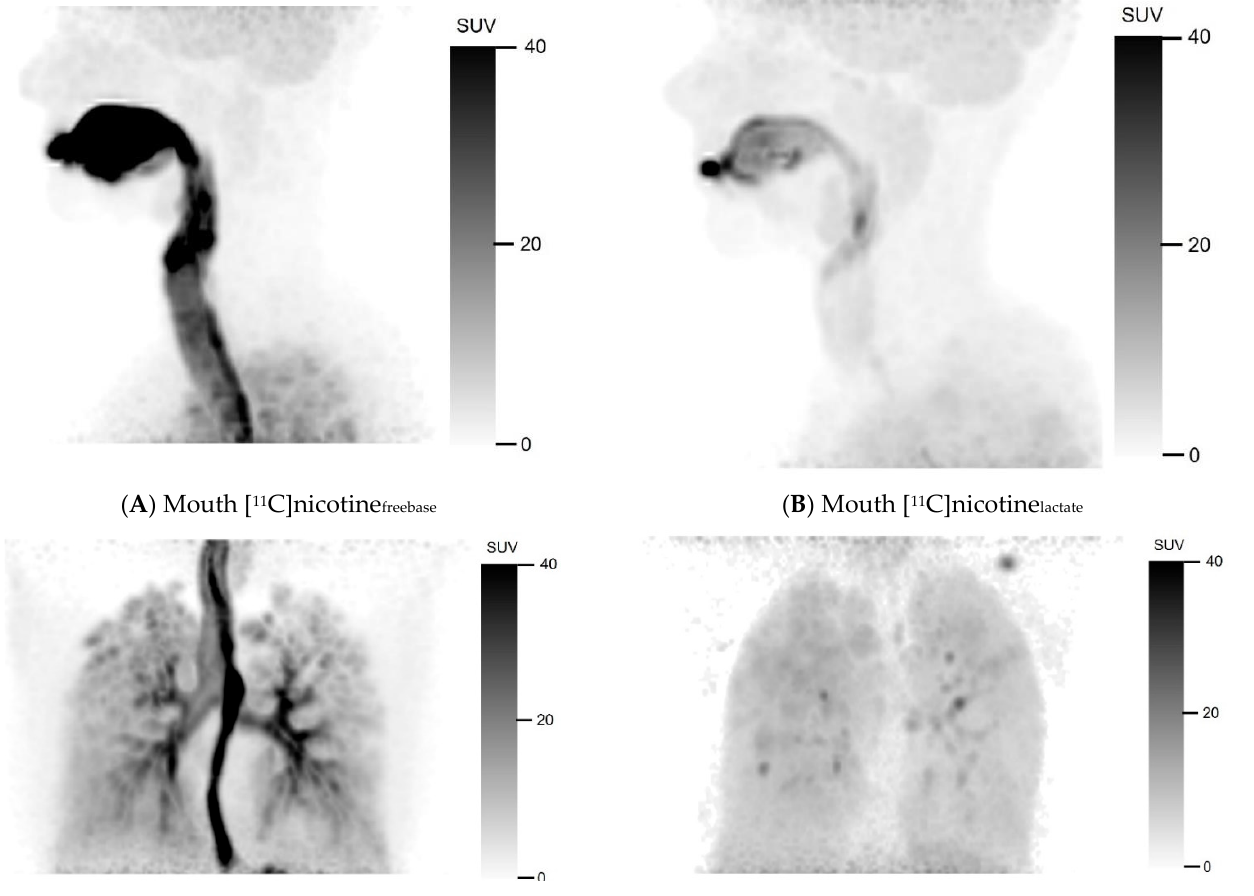
Figure 1. Mouth and lung summation PET images illustrating uptake of [ 11 C]nicotine using freebase ( A , C ) and lactate ( B , D ) formulations, for one representative subject in each cohort. Summation was performed from first frame after inhalation without device to 10 min post inhalation.